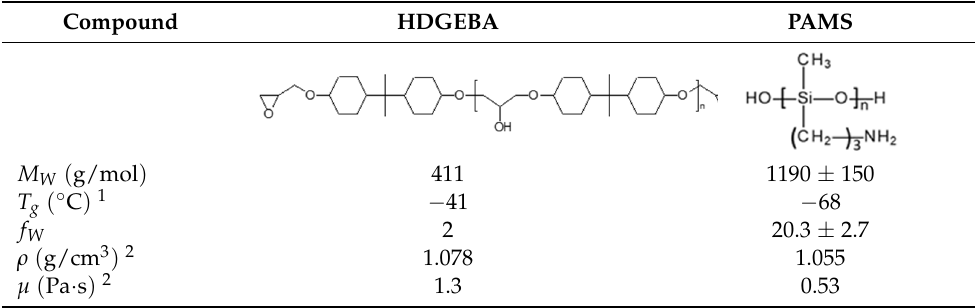
Table 1. Chemical formulae, weight average molecular mass and functionality, glass transition temperature, density, and viscosity of precursor compounds. Compound